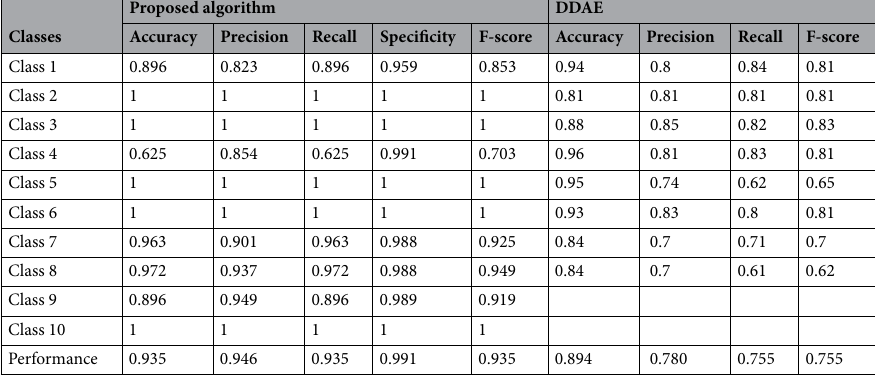
Table 4. Performance of each class measured as the average of different normalization techniques.